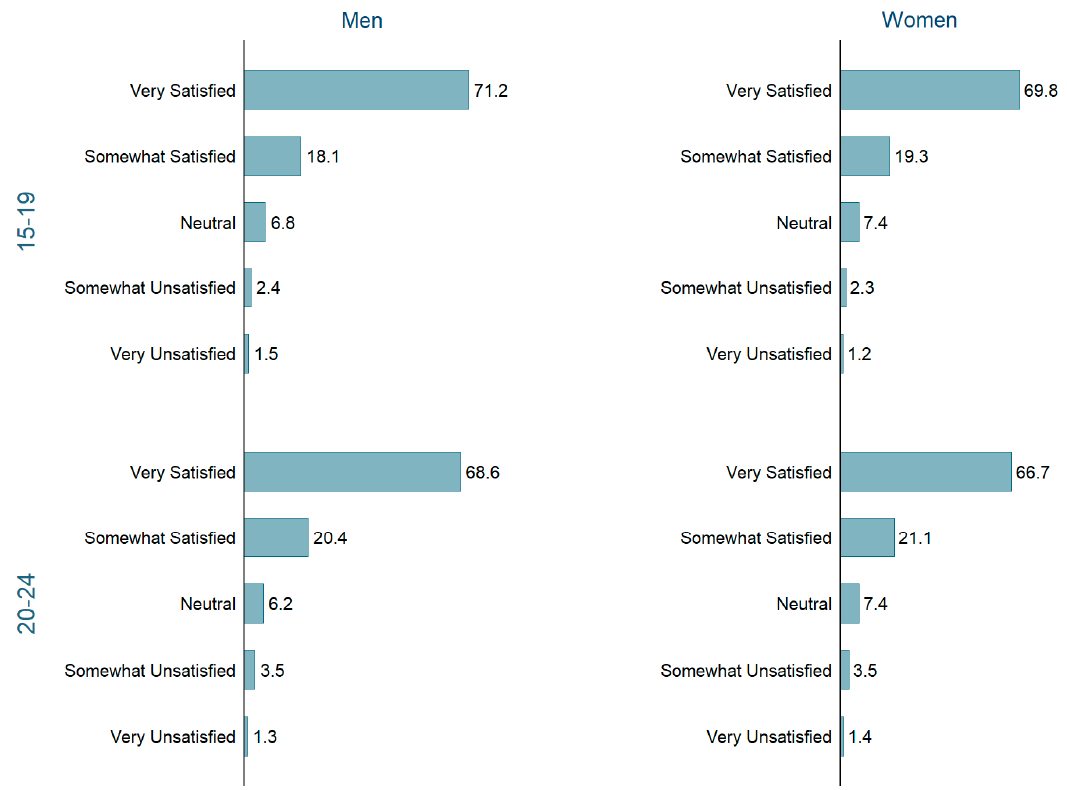
Figure 3. Proportion of men and women by self-reported health status.